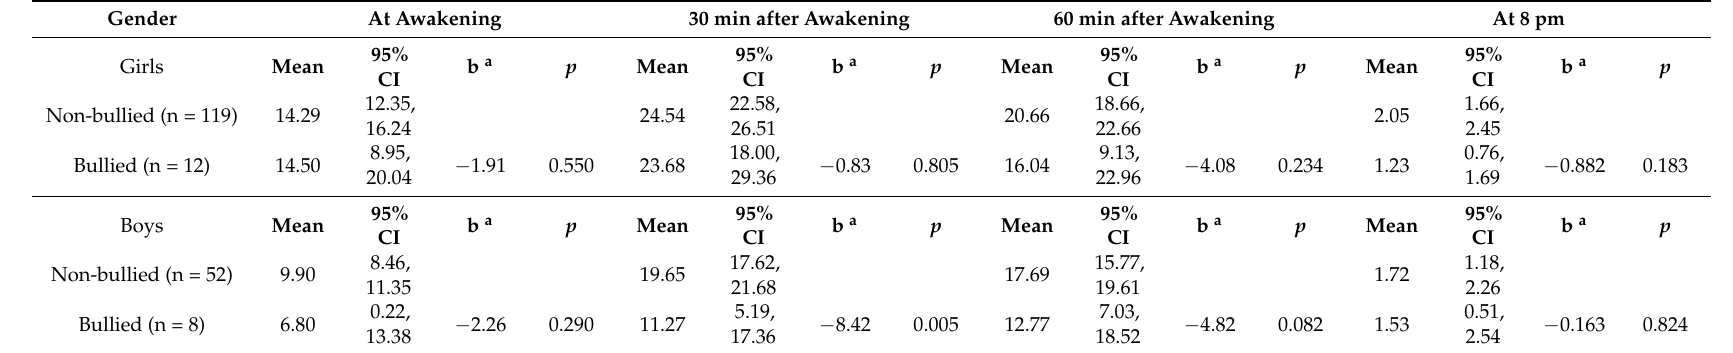
Table A1. Cortisol output (nmol/L) at four time points during one day. Mean values and 95% confidence intervals, and b coefficients and p -values from gender-separate linear regressions with non-bullied girls and non-bullied boys as the reference